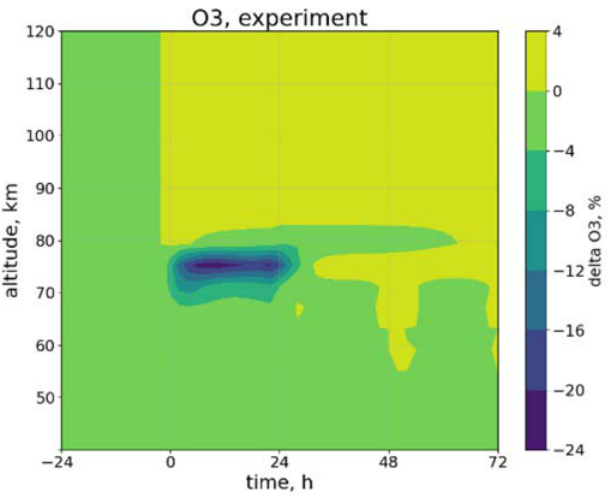
Figure 2. Ozone changes after EEP. The 0 on the horizontal axis is midnight of 10 May